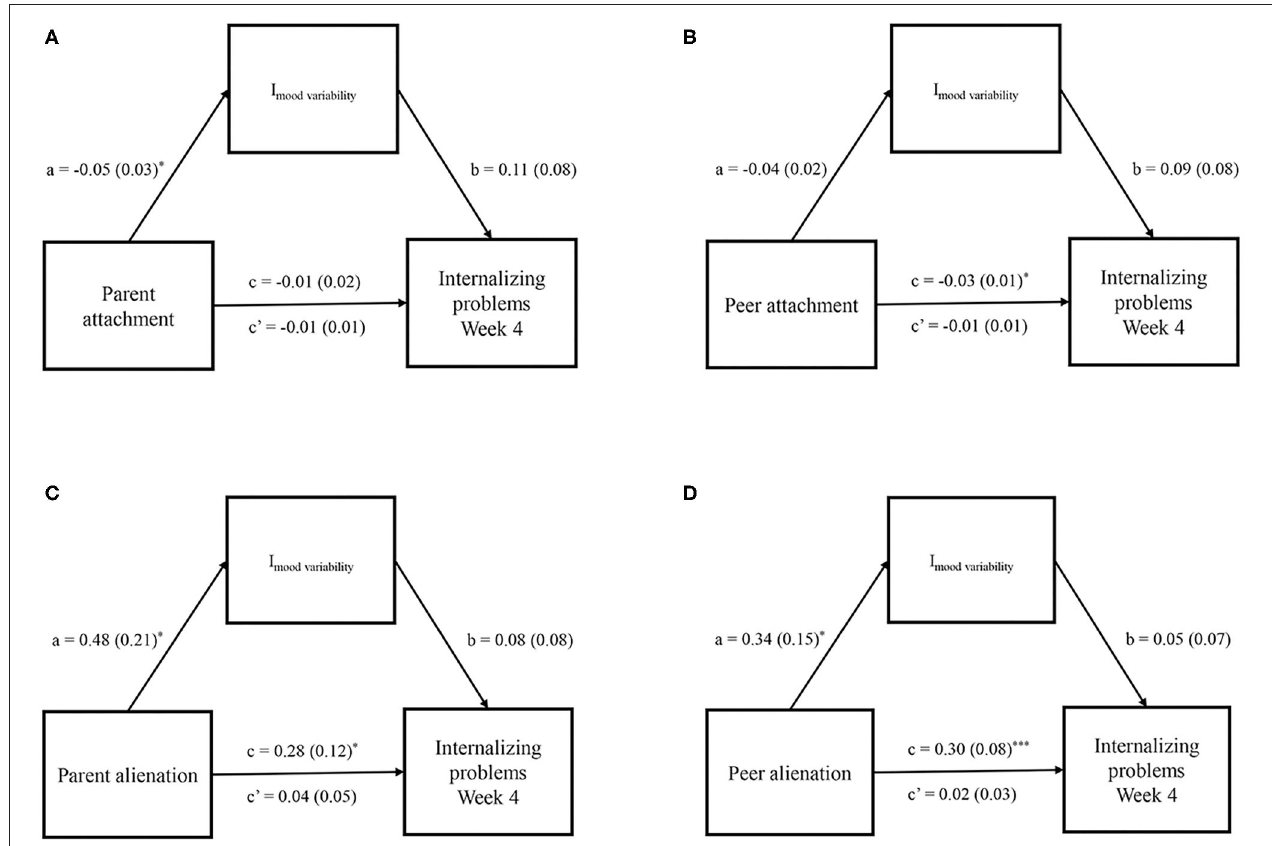
FIGURE 3 | Adolescents’ individual intercept op mood variability as mediator between parent attachment (A) , peer attachment (B) , parent alienation (C) , peer alienation (D) , and internalizing problems at the last assessment. * p < 0.05 and *** p < 0.001.